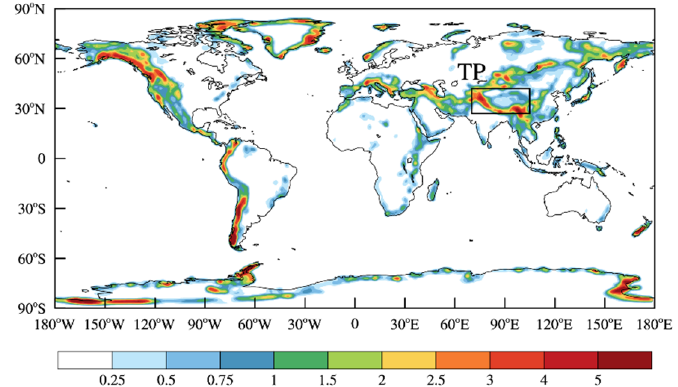
Figure 1. Global climatology of the surface wave momentum flux (SWMF) (units: N m − 2 ) during 1979–2017 from the ERA-Interim reanalysis. The Tibetan Plateau (TP) is indicated by the black rectangular box.